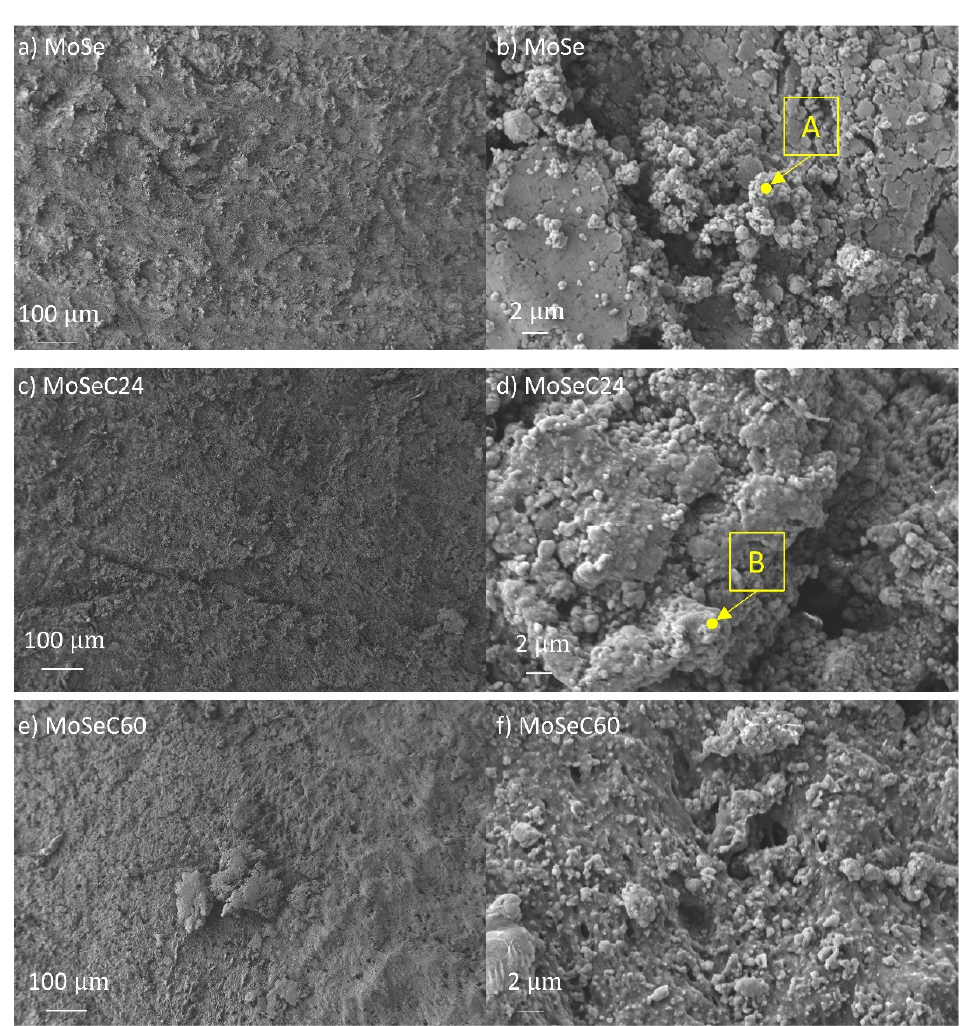
Figure 10. Micrographs of the wear tracks for the Mo-Se-C coatings after POD experiments against rubber at 25 °C: ( a ) MoSe at lower magnification (LM) imaging; ( b ) detailed features of the MoSe at high magnification (HM) imaging; ( c ) MoSeC24 at LM imaging; ( d ) detailed features of the MoSeC24 at HM imaging; ( e ) MoSeC33 at LM imaging; ( f ) MoSeC33 at HM imaging; ( g ) MoSeC51 at LM imaging; and ( h ) MoSeC51 at HM imaging.